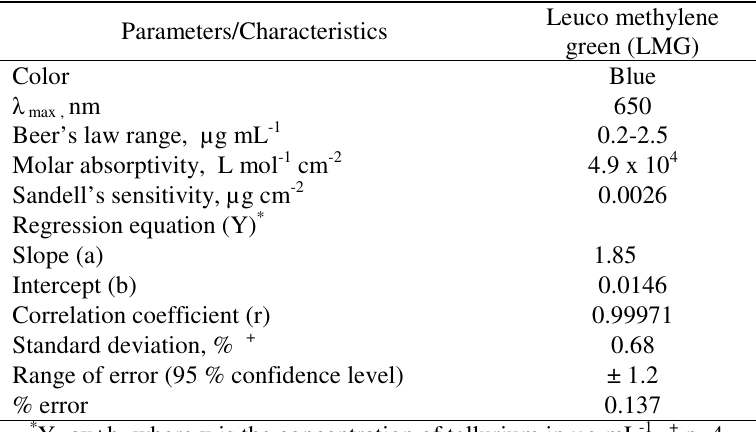
Table 1. Optical characteristics and precision